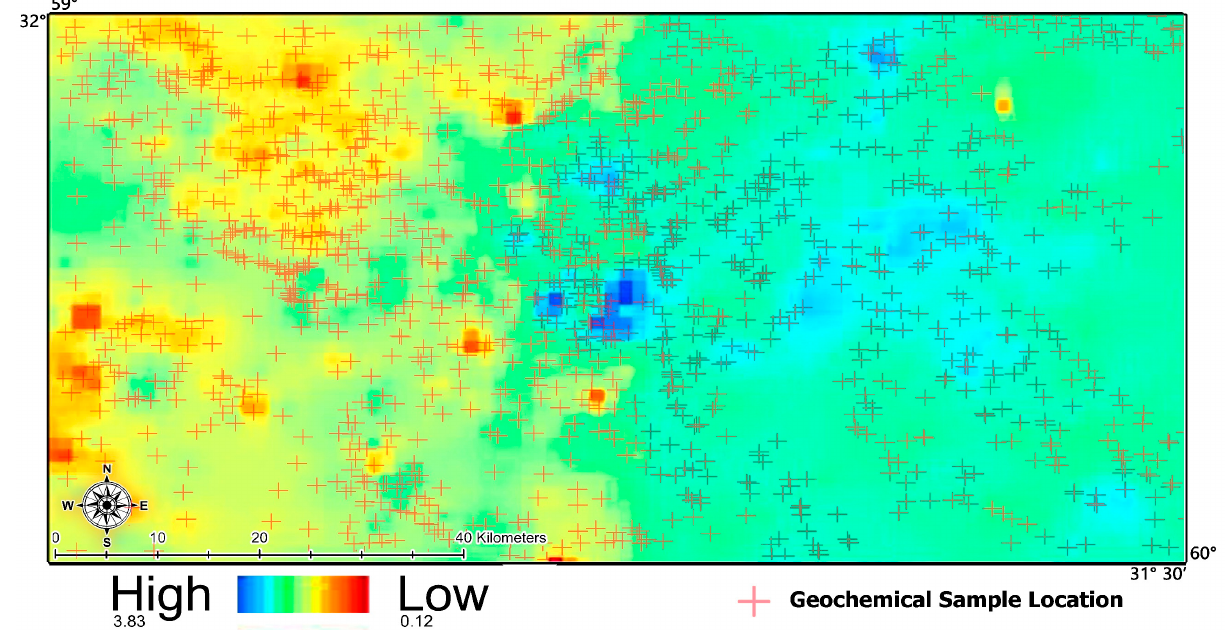
Figure 19. Singularity map of zonality index—(Pb*Zn*Bi)/(Cu*Mo*Ag).